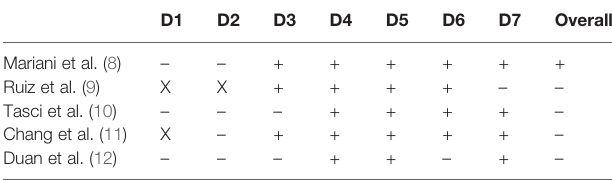
TABLE 1 | ROBINS-I Assessment of Non-randomized studies: D1, Bias due to confounding; D2, Bias in selection of participants into the study; D3, Bias in classi fi cation of interventions; D4, Bias due to deviations from intended interventions; D5, Bias due to missing data; D6, Dias in measurement of outcomes; D7, Bias in selection of the reported result; X, high; – , some concern; +,